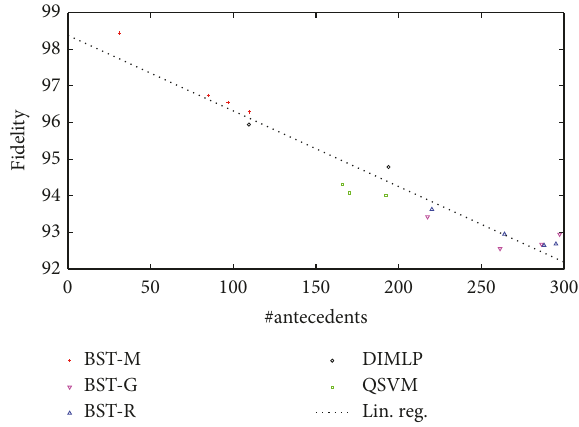
Figure 9: Plot of average fidelity versus average number of antecedents per